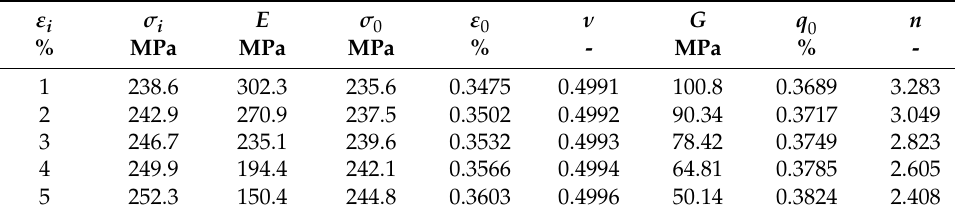
Table 1. Dependence of material parameters on selection of calibration point ( ε i , σ i ) .